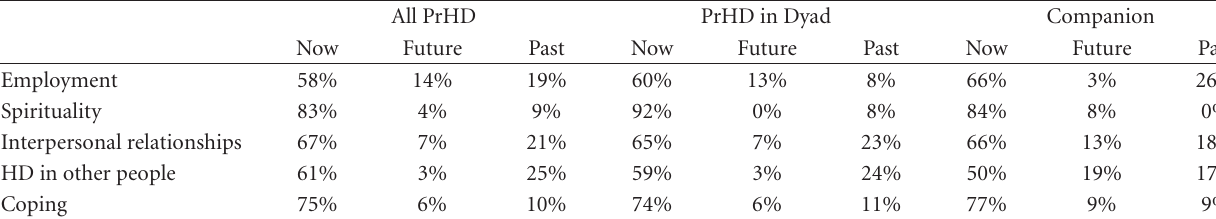
Table 6: Time frame of QOL statements by content